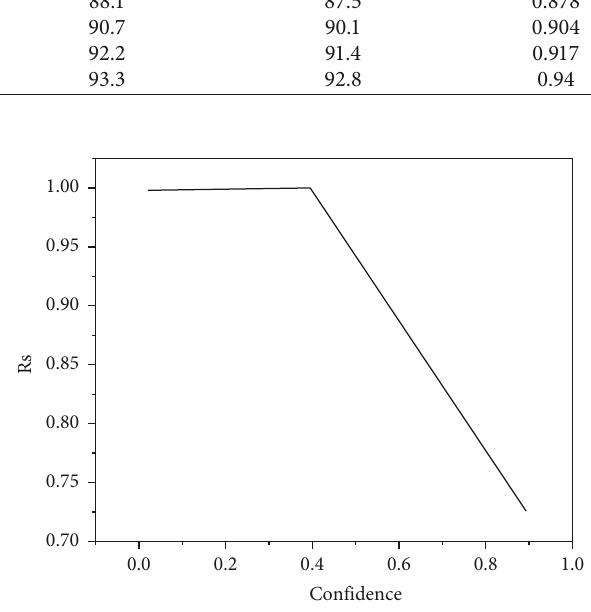
Figure 7: Recall rate curve of classified